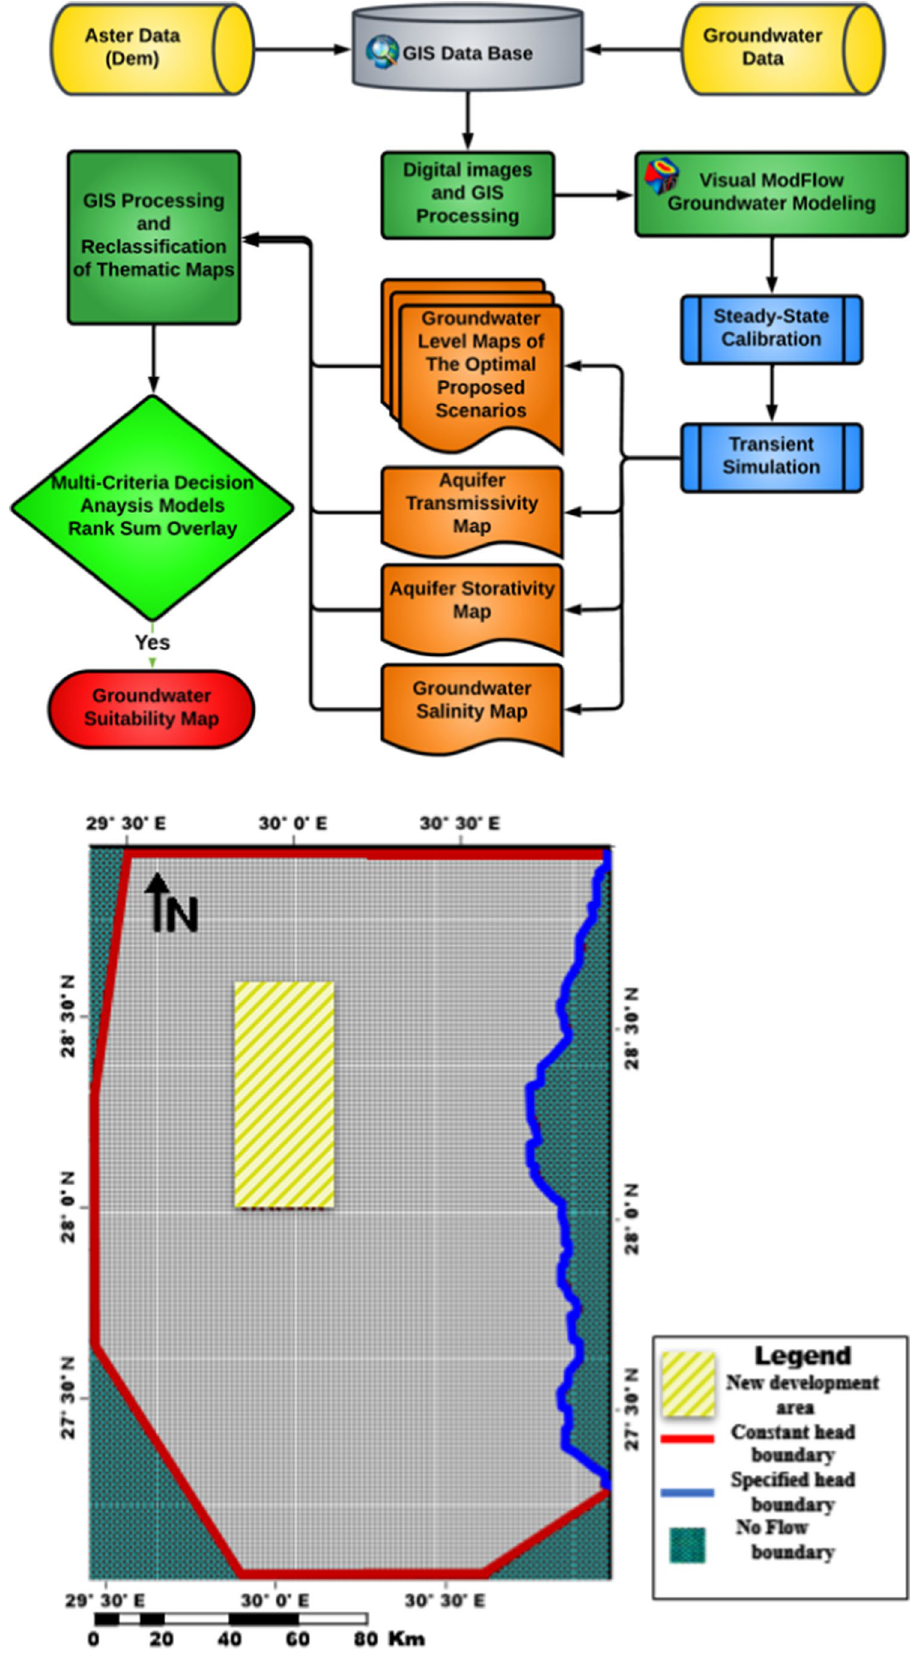
Fig. 8 Flowchart of work procedure